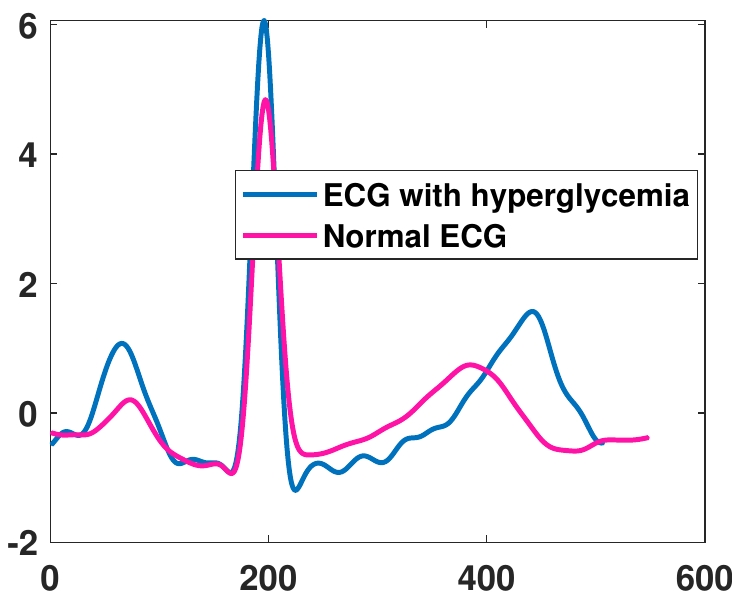
Figure 5. ECG signal from a person with hyperglycemia and without